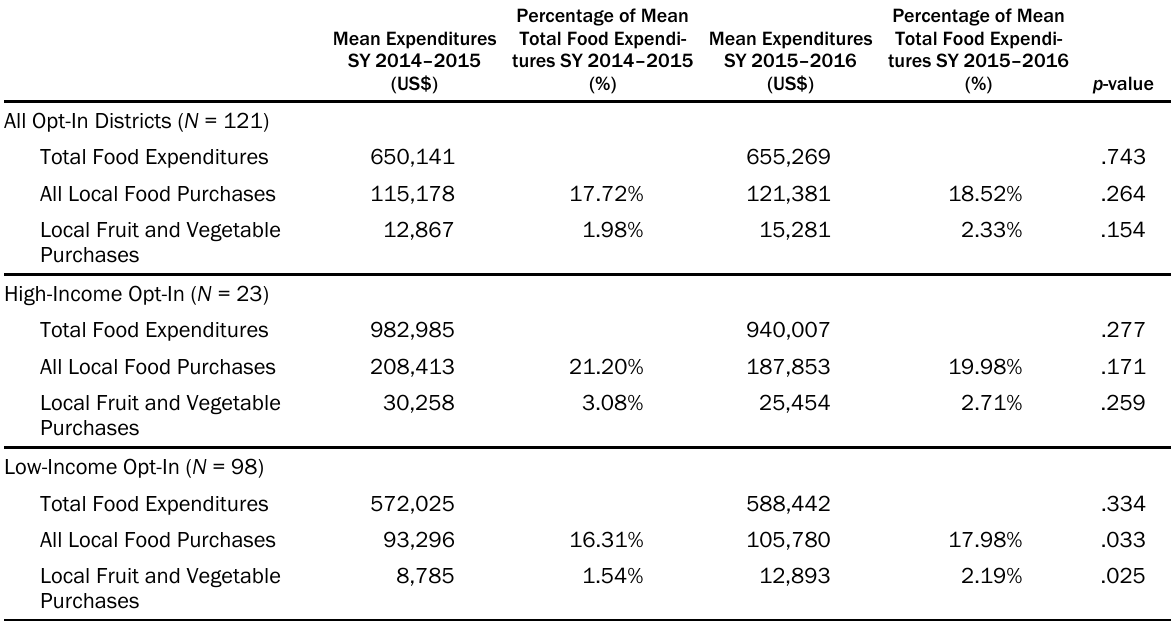
Table 3. Local Food Purchases for 2014–2015 and 2015–2016 for Opt-In